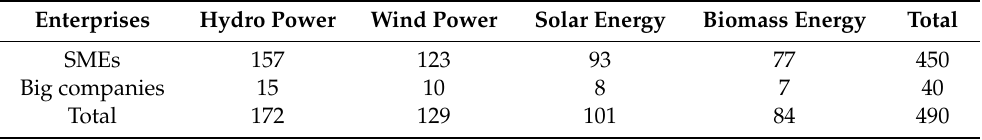
Table 3. Distribution of the RES enterprises by type in 2017.